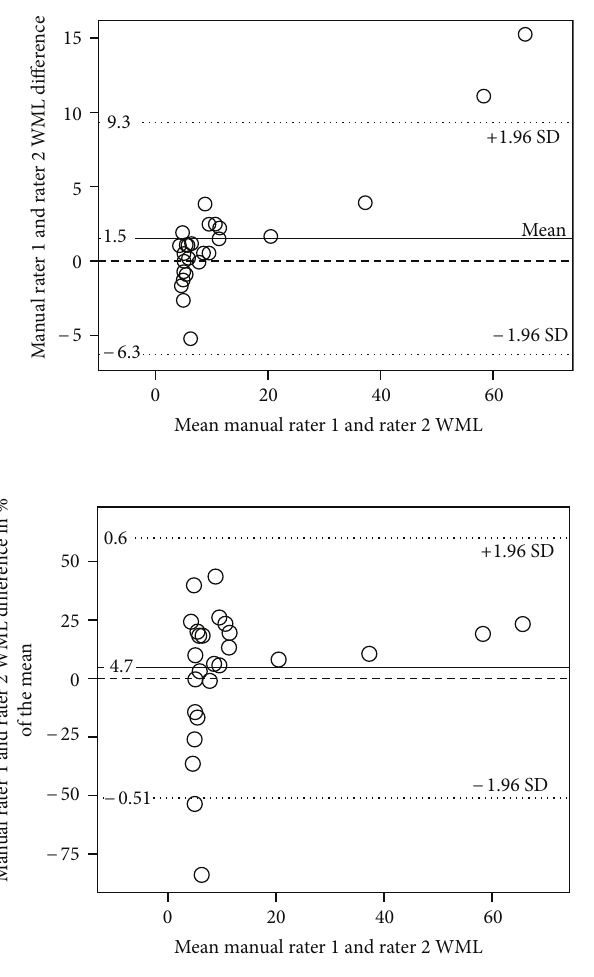
F 3: (a) and (b) Bland-Altman plots of the interrater dif- ferences for the manual MRIcron WML method in cm differences in (a) image and fractional difference of mean volume in (b). e dashed line designates the no differences level.